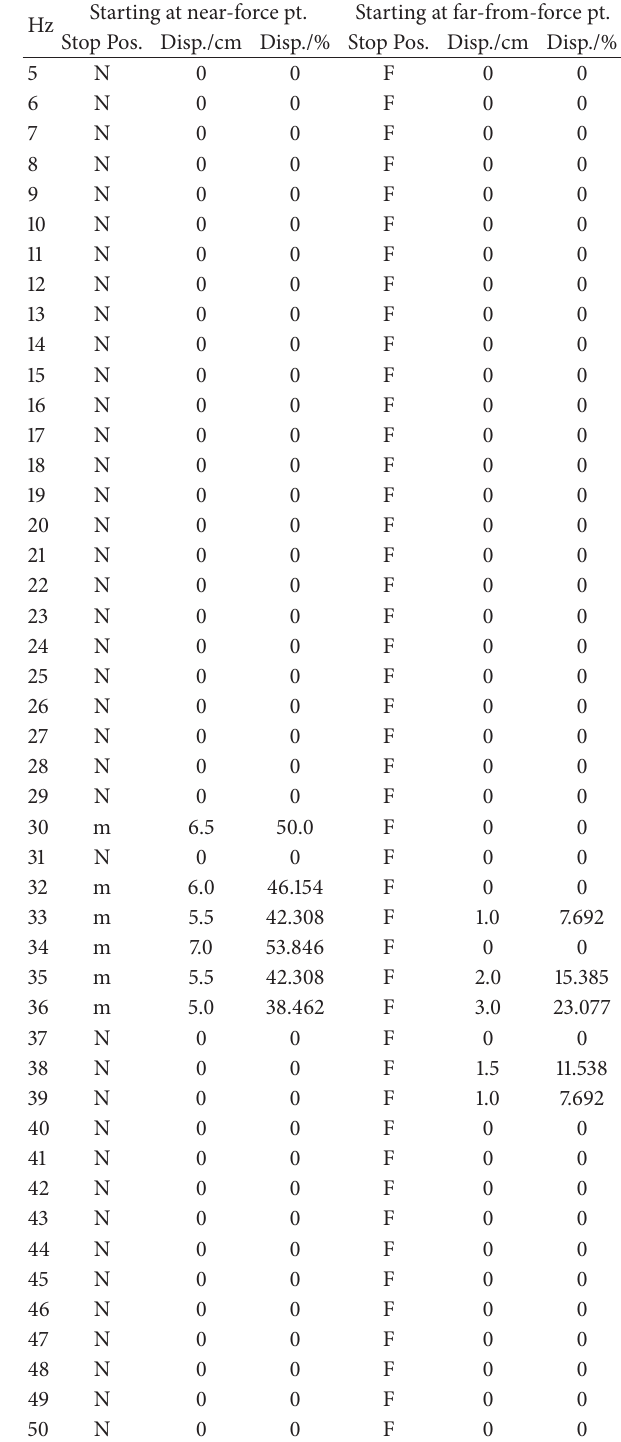
N = near-force, F = far-from-force, m = middle-of-groove.